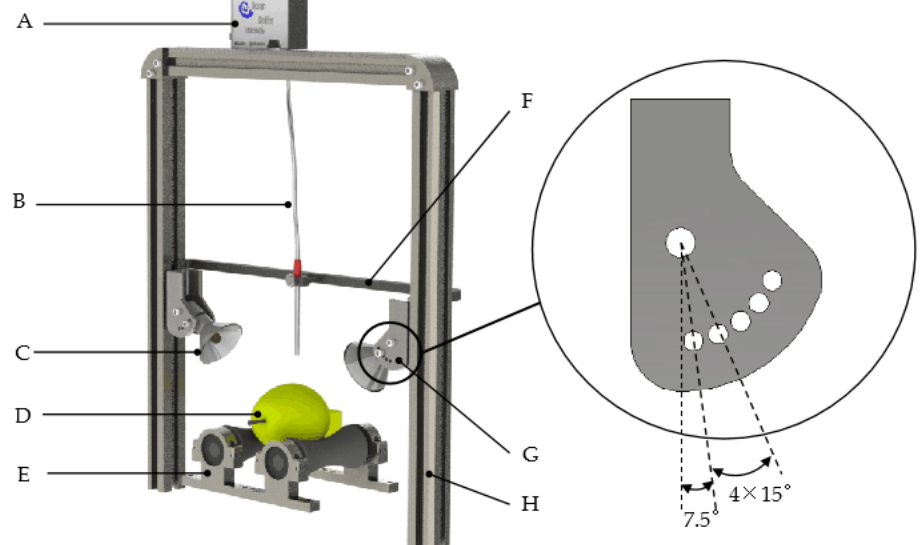
Figure 1. Vis/NIR spectra acquisition system for Korla fragrant pears. A: spectrometer; B: optical fiber; C: halogen lamp; D: sample; E: rotating stage; F: optical fiber bracket; G: lamp mounting plate; H: system mounting rack.